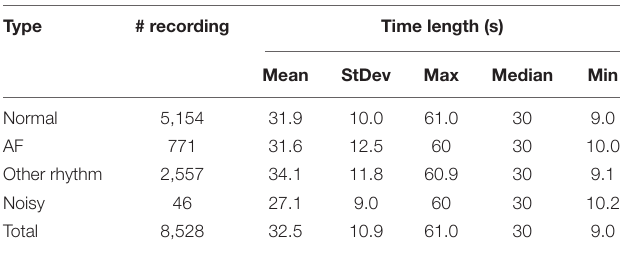
TABLE 1 | Data profile of PhysioNet challenge 2017